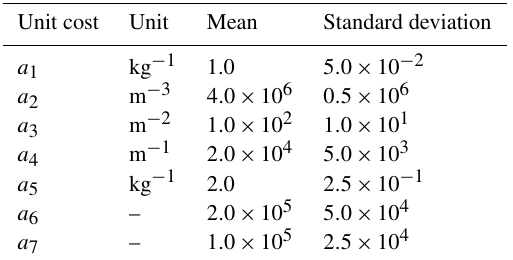
Table 5. Reference unit costs for the considered example, a 5MW reference turbine in a water depth of